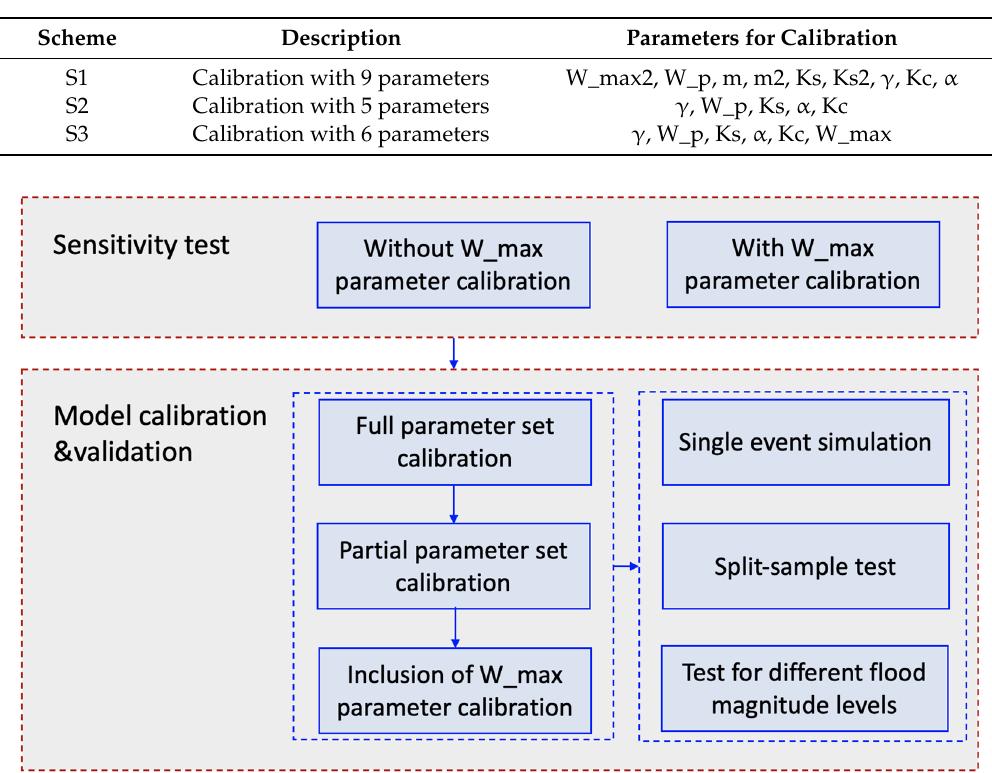
Table 4. Calibration schemes using the MISDc-2L model.